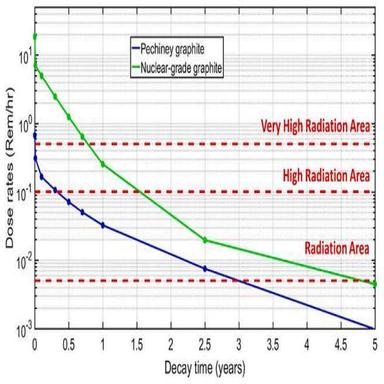
Dose rate evaluated at 30 cm from the source (container of first-time irradiated graphite).